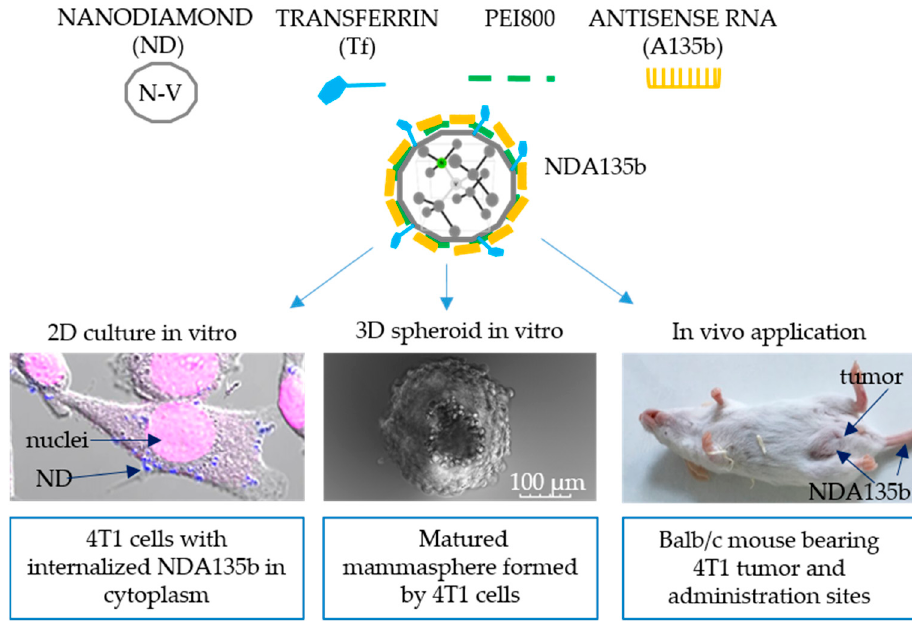
Figure 1. Composition of nanodiamond-based complex with multiple functionalization and its application onto a sequence of biological models from the easiest 2D cell culture via 3D differentiated mammospheres towards local and systemic in vivo administrations.